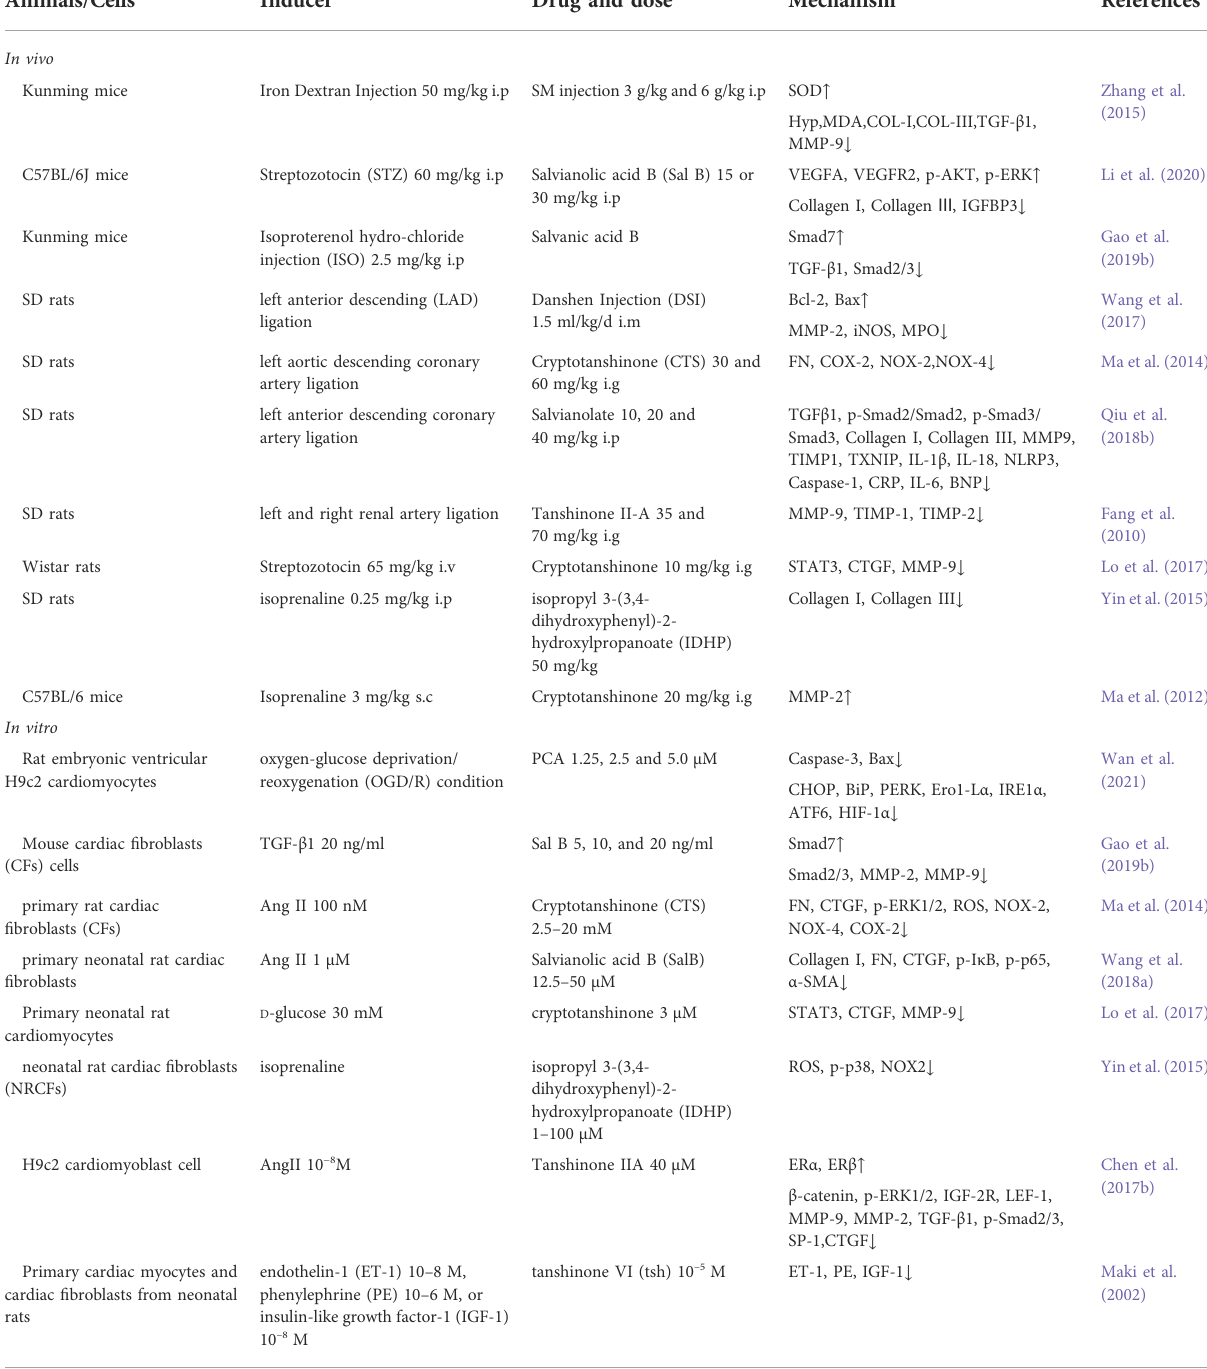
TABLE 4 Effects of SM and its active ingredients against myocardial fi brosis in vivo and in vitro .